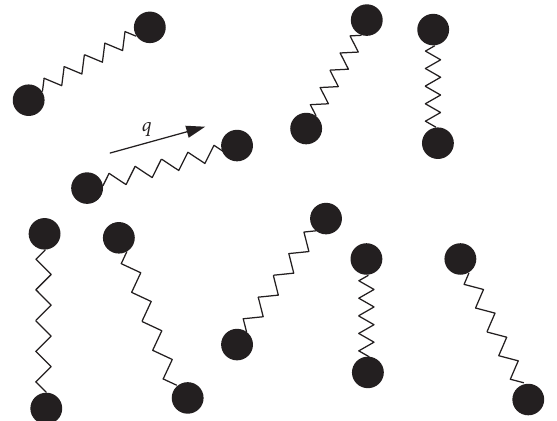
Figure 2: Polymer molecules modeled as an ensemble of bead- spring-spring chains.